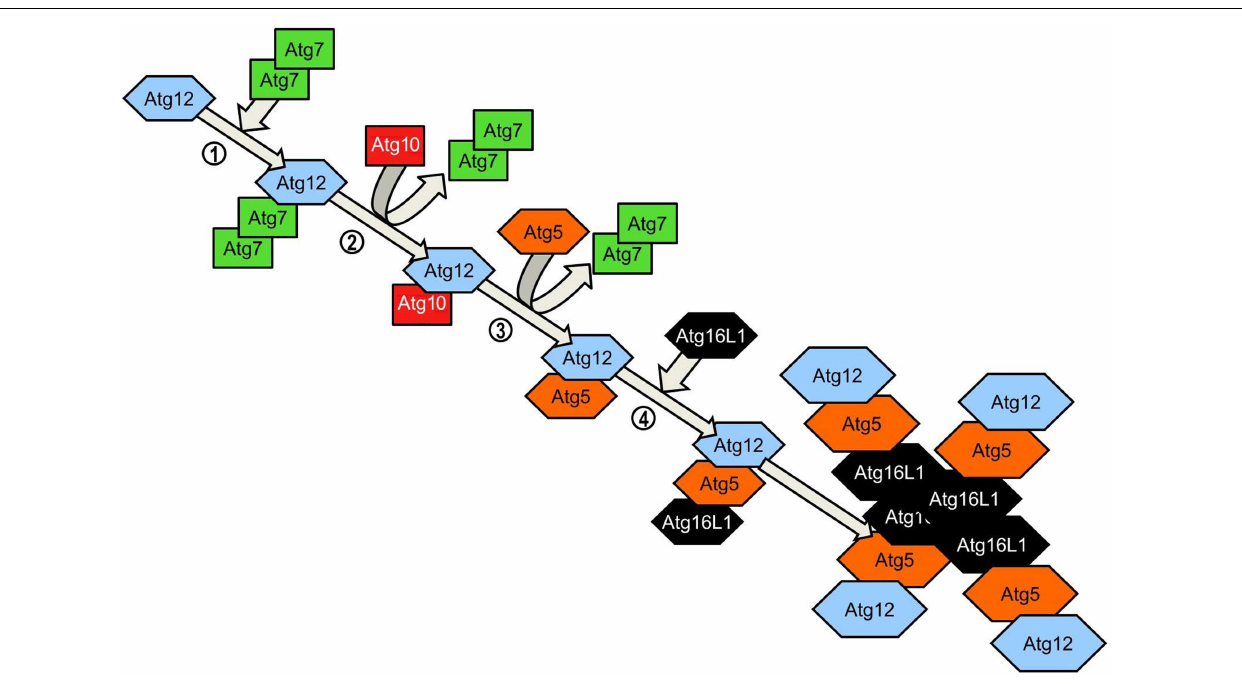
linkage. Atg10 catalyzes the formation of an irreversible isopeptide bond between the Atg12 C-terminal glycine and Atg5. After the formation of the Atg5-Atg12 conjugate, Atg16L1 associates with the complex, binding non-covalently with Atg5. Interaction between Atg16 coiled-coil domains on adjacent Atg5-Atg12-Atg16L1 conjugates results in the formation of tetrameric